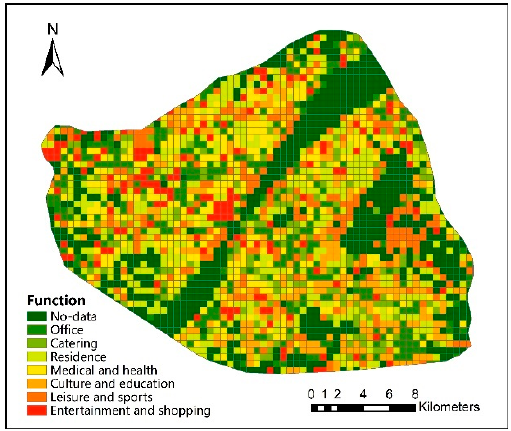
Figure 9. Functional distribution based on POI data